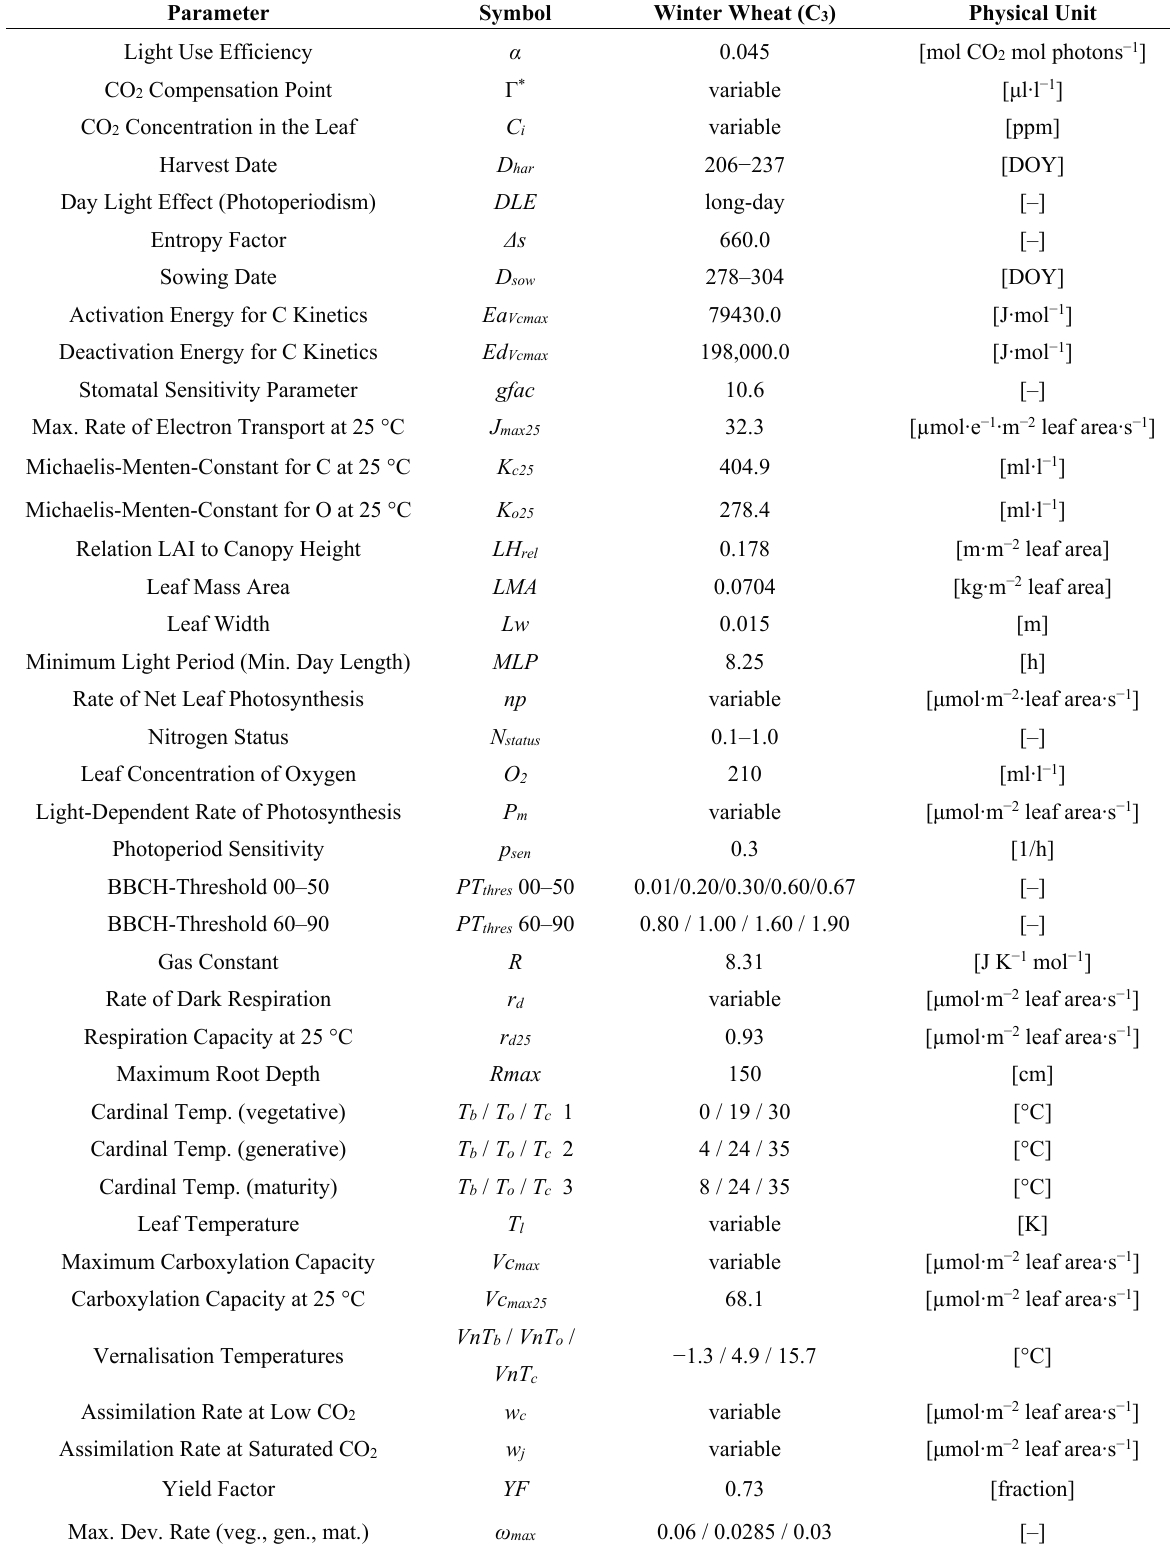
Table 1. PROMET Model parameters and variables applied for the simulation of winter wheat